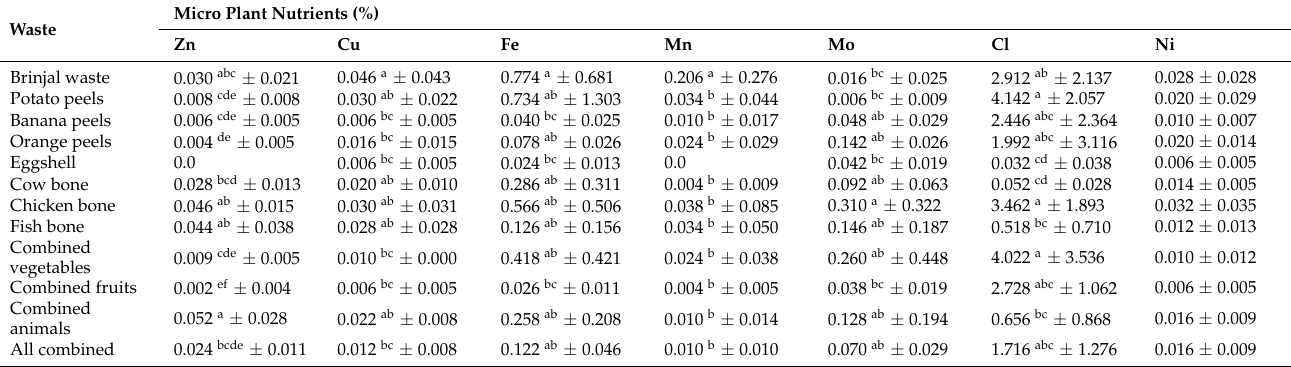
Table 3. Micro plant nutrient content of different food wastes.